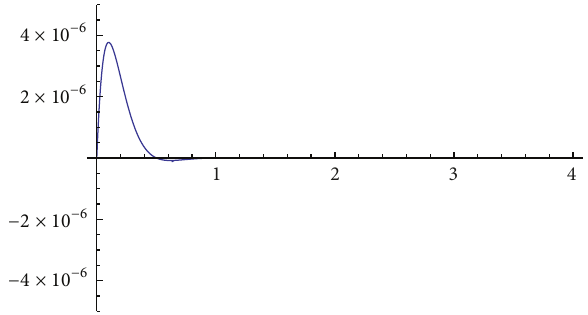
Figure 3: Graph of the error of our approximation: 𝐹 5/2 (ℎ) − (ℎ) 𝑒 −(ℎ 2 /2) [3/5] 𝐺